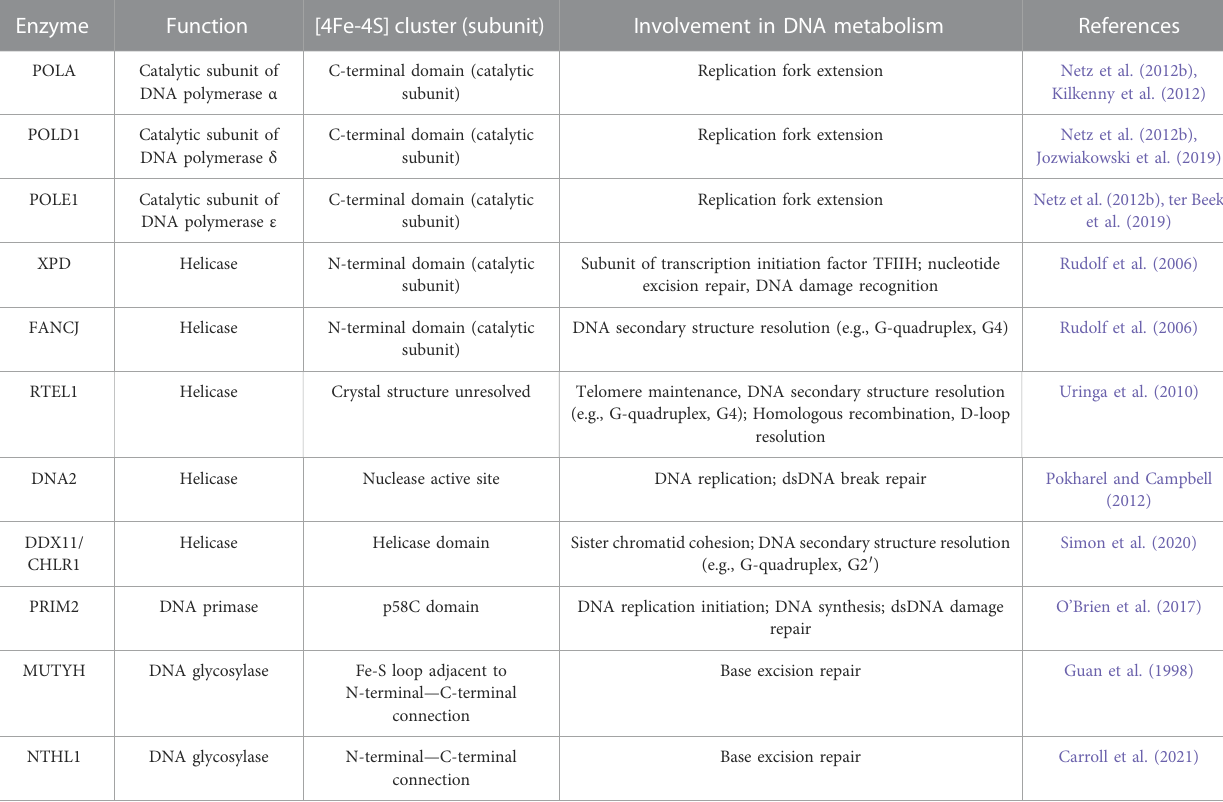
TABLE 1 [4Fe-4S] cluster enzymes involved in DNA